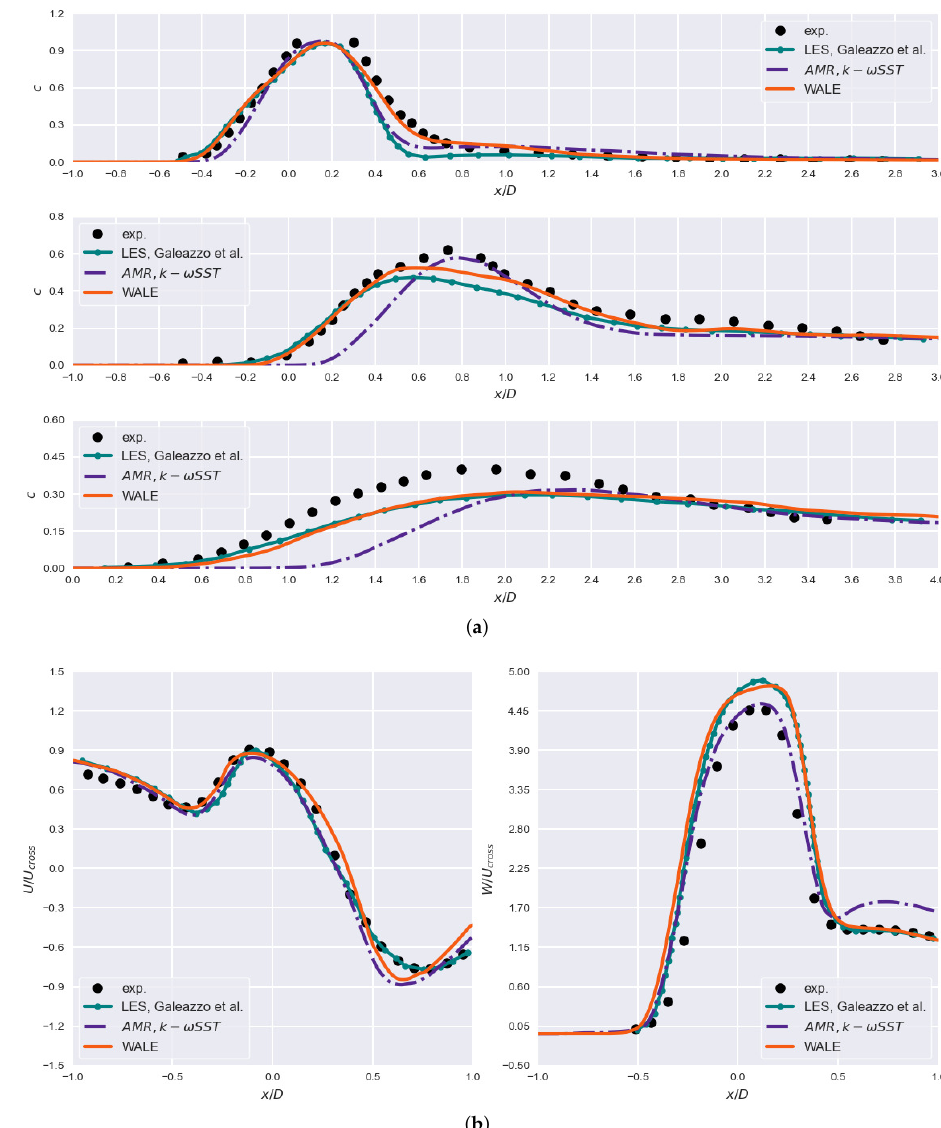
Figure 11. Results obtained using the WALE model and AMR: ( a ) concentration of passive scalar c at z / D = 1.5, z / D = 3, z / D = 4.5 (top to bottom) where y / D = 0; ( b ) profiles of mean velocity components for y / D = 0 and z / D = 1.